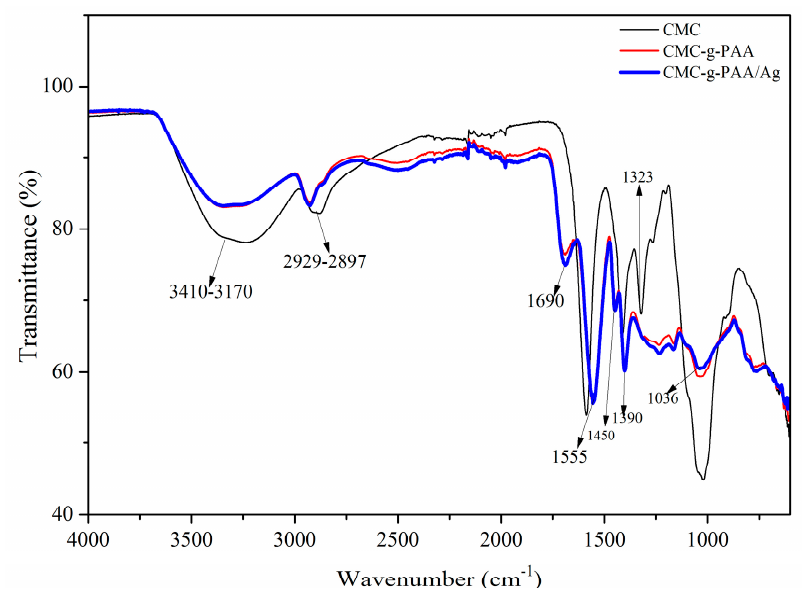
Figure 2. Fourier transform infrared spectroscopy (FTIR) spectra of carboxymethyl cellulose (CMC), CMC-g-PAA and CMC-g-PAA/Ag.